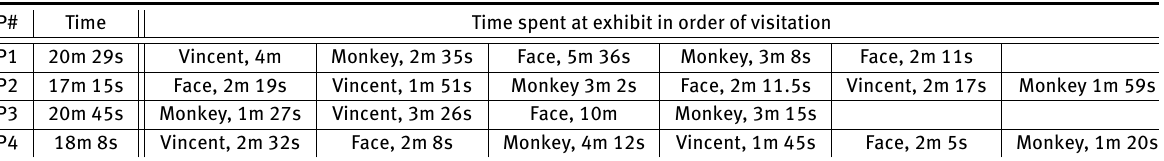
Table 2. Summary of first in-robot gallery visitation